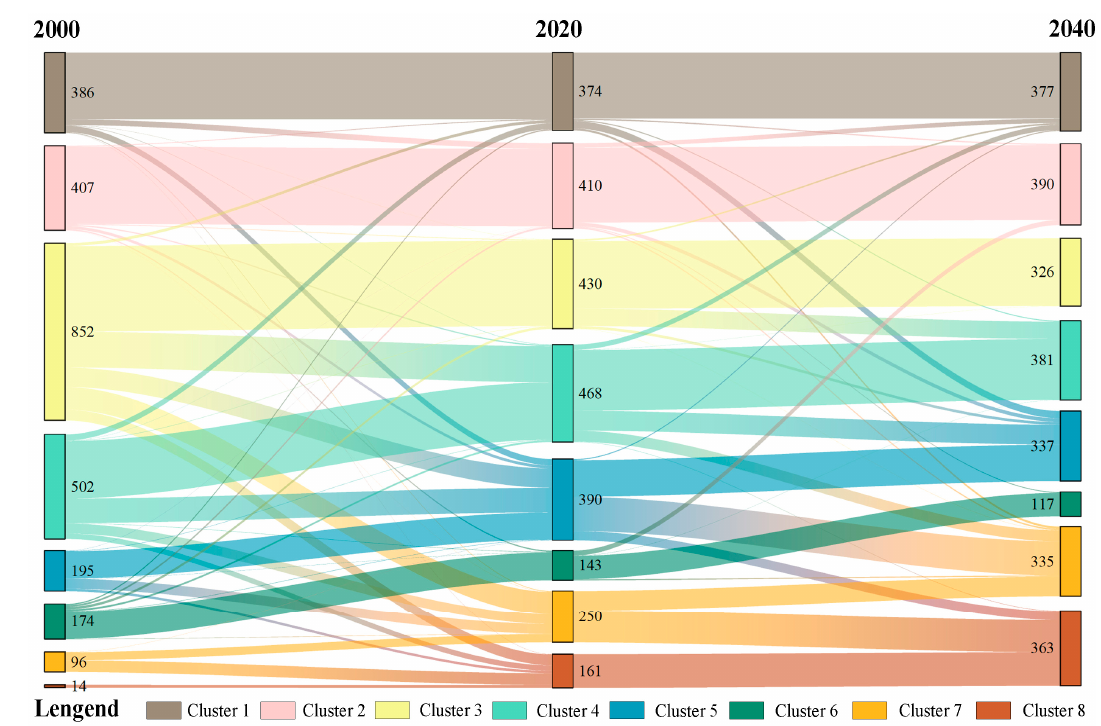
Figure 7. Spatial distribution of LCT in 2000, 2020, and 2040.